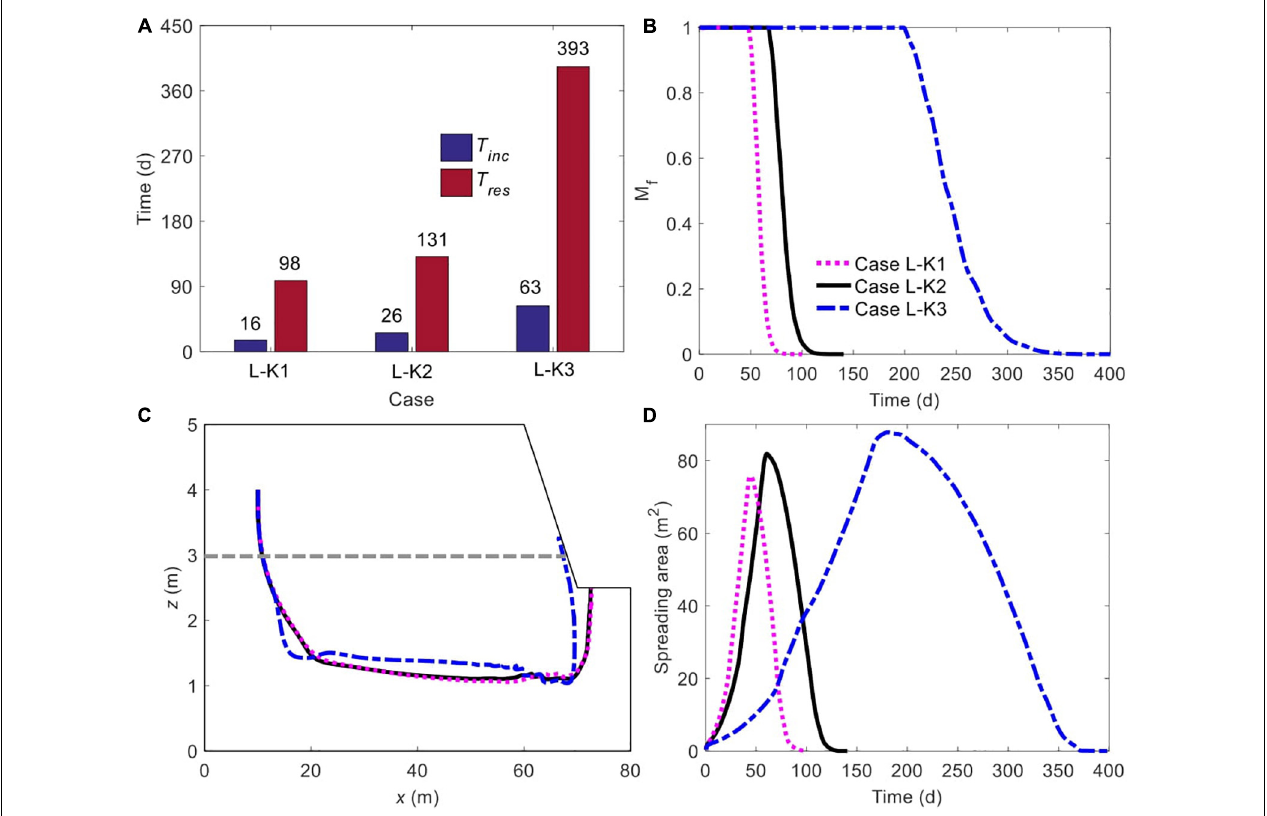
FIGURE 8 | Comparison of (A) initiation time of unstable flow and residence time of solute plume, (B) time-dependent, normalized amount of solute mass remaining in marsh soil, (C) spatiotemporal variation of plume centroid, and (D) plume spreading area for different ratios of K mud / K sand . The plume edge was determined based on the concentration of 0.0001 C 0 . The gray dashed line in panel (C) represents the boundary between mud layer (upper) and sand layer